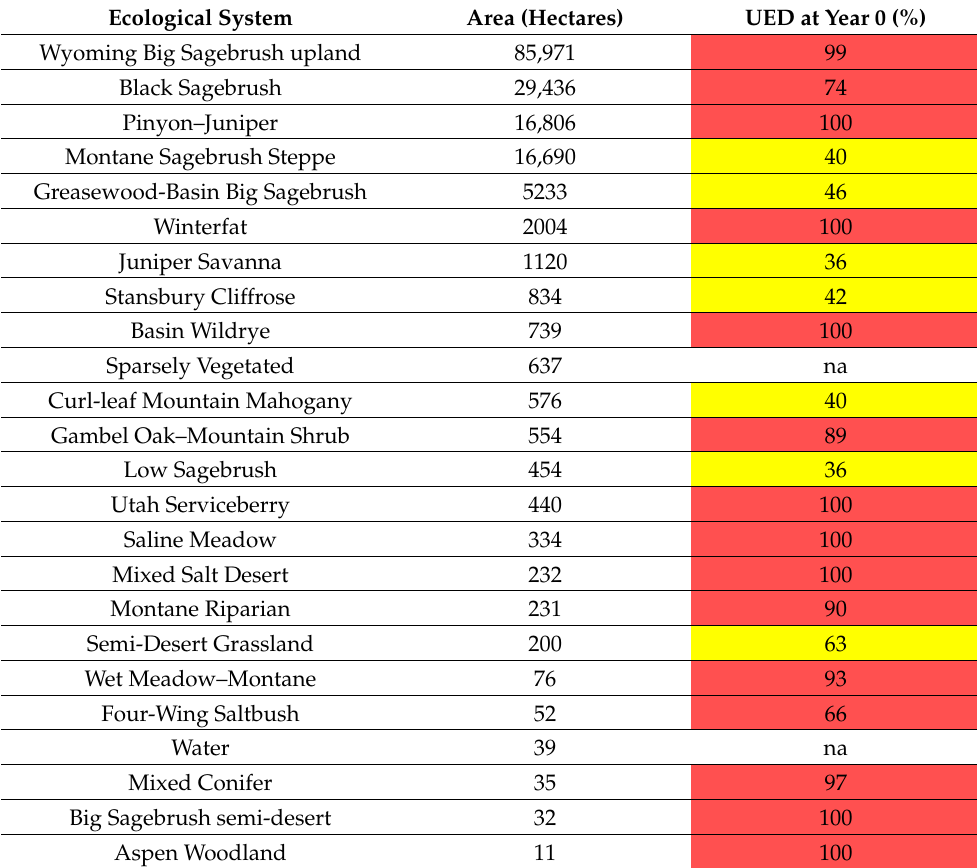
Table 5. Area (ha) and unified ecological departure (UED) of ecological systems mapped in the Black Mountains (UT). UED color legend: red is >66% and 33% < yellow ≤ 66%. Ecological System Area (Hectares) UED at Year 0 (%) Wyoming Big Sagebrush upland